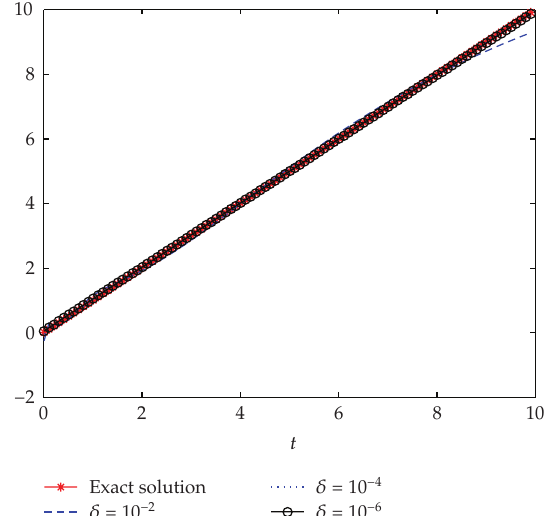
Figure 10: Example 3.10: the stability of the approximate solution.